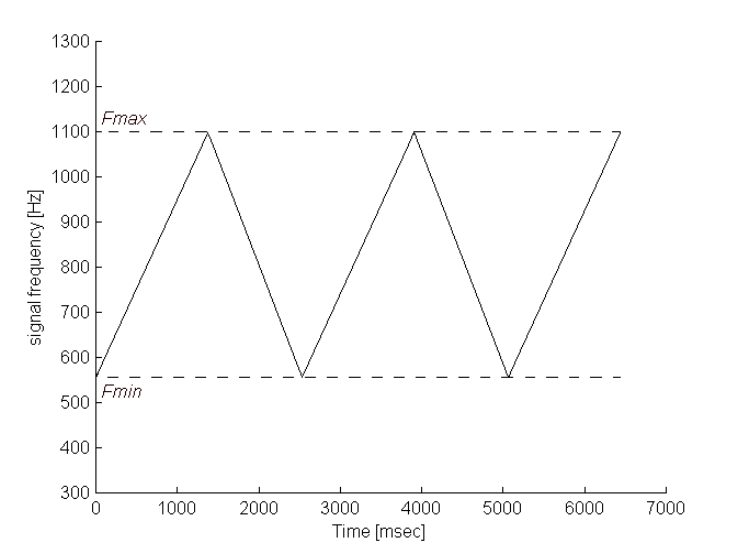
Figure 1. A typical frequency characteristic curve of a